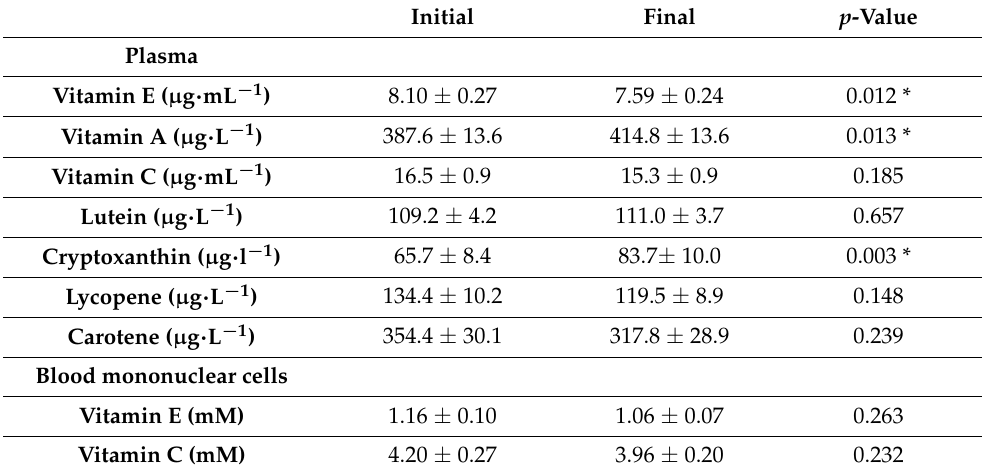
Table 5. Changes in vitamin and carotene concentrations in plasma and blood mononuclear